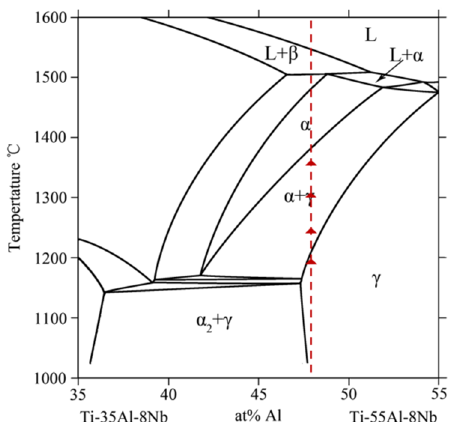
Figure 6. Curve of bending strength of Ti-48Al-2Cr-8Nb alloy with sintering temperature and ambient temperature. ( a ) Sintered by the SP powder and ( b ) sintered by the MP powder.